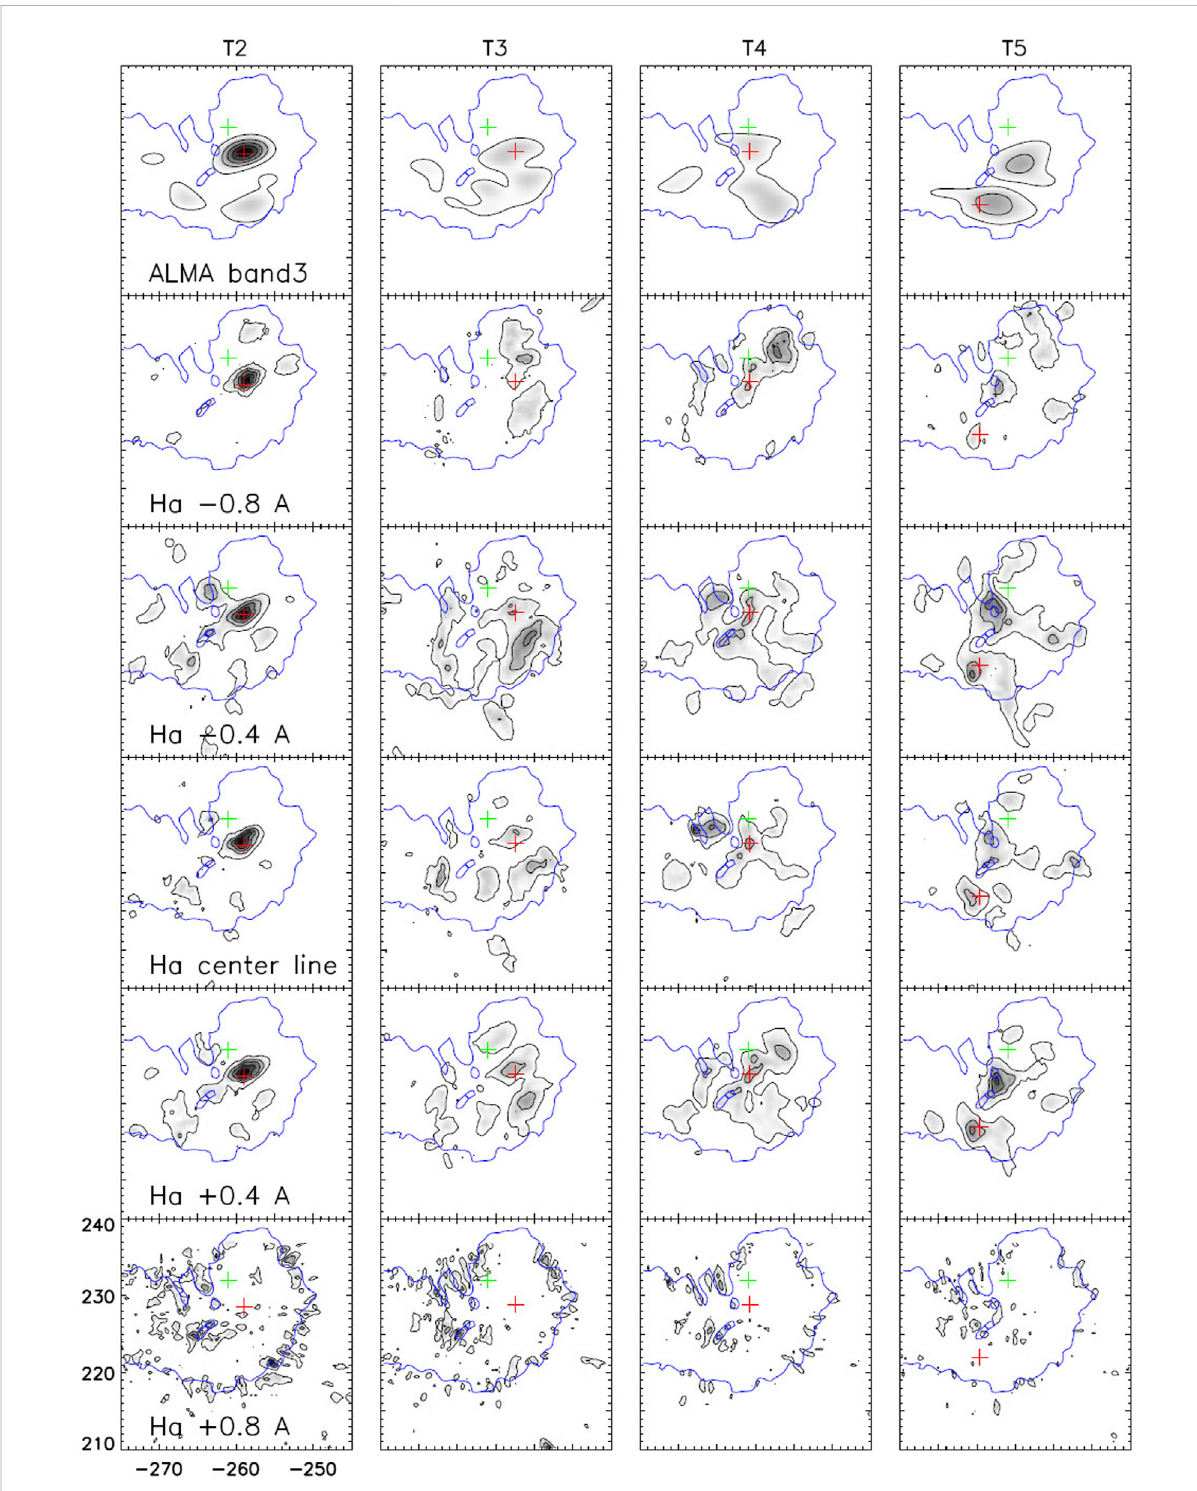
FIGURE 5 Spatial distribution of the 3-min oscillation power amplitude in 3 mm (top row) and in various sub-bands along the H α line. The columns correspond to different ALMA solar scans, each of duration of about 10 min (from Chai et al., 2022). © AAS. Reproduced with